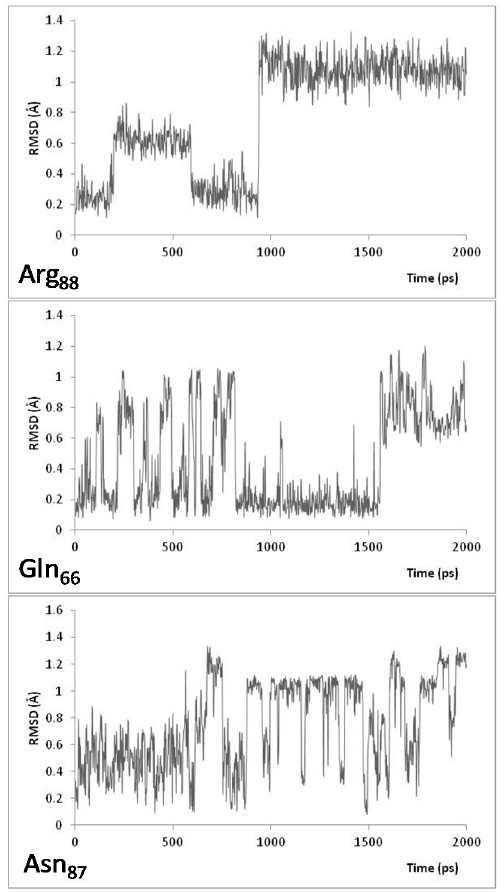
Figure 1. Plots of the Root Mean Square Deviation (RMSD) of Arg88, Gln66, and Asn87 over the course of 2 ns MD simulations, at 300 K, of the P450-TT enzyme.